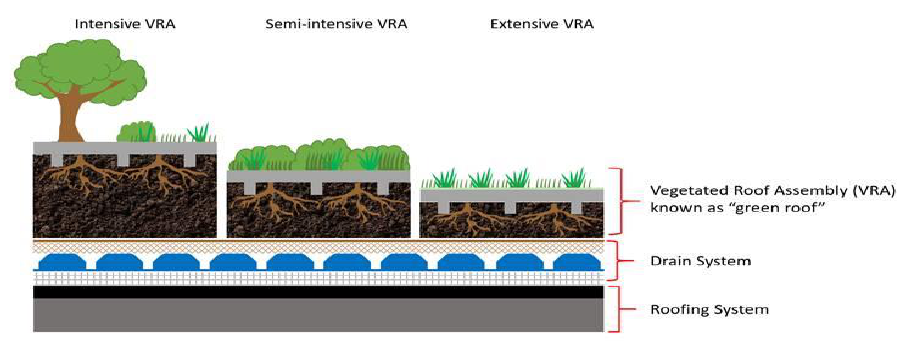
Figure 1. Typical components and configurations of green roofs, based on [29].